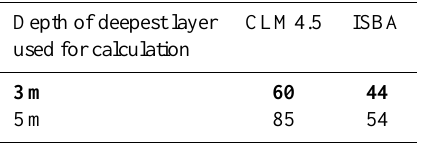
Table 6. Derived permafrost area (10 4 km 2 ) with deeper soil layers using the TSL method. The results for thresholds commonly used in the literature and in this paper are marked in